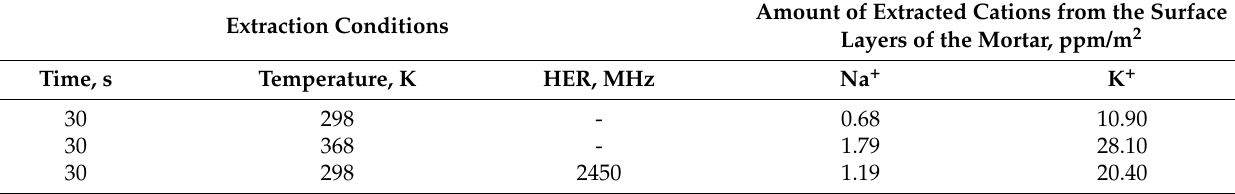
Table 5. The effect of extraction conditions on the amount of extracted